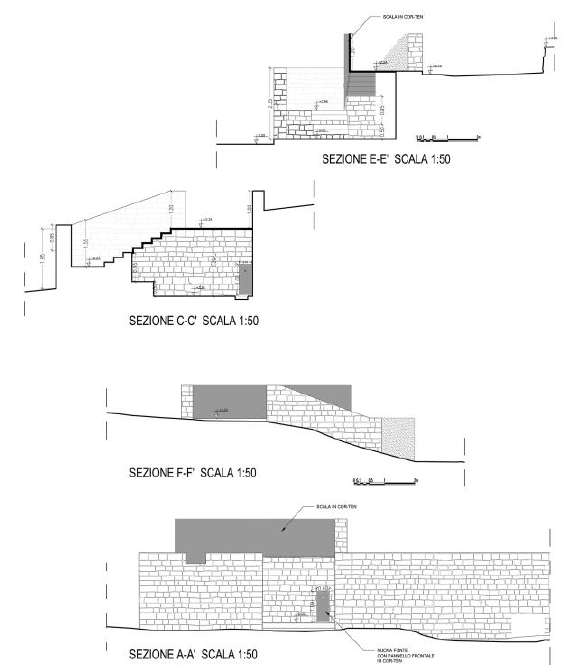
Figure 8. construction project of the small building.